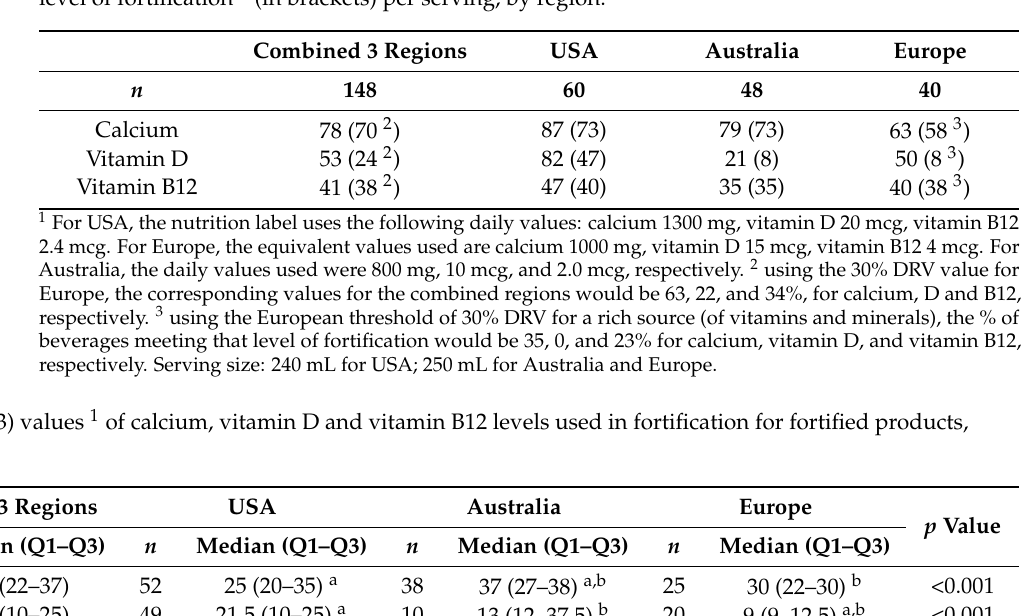
Table 1. Percentages of non-dairy beverages that are fortified, and those meeting the 20% daily value level of fortification 1 (in brackets) per serving, by region.